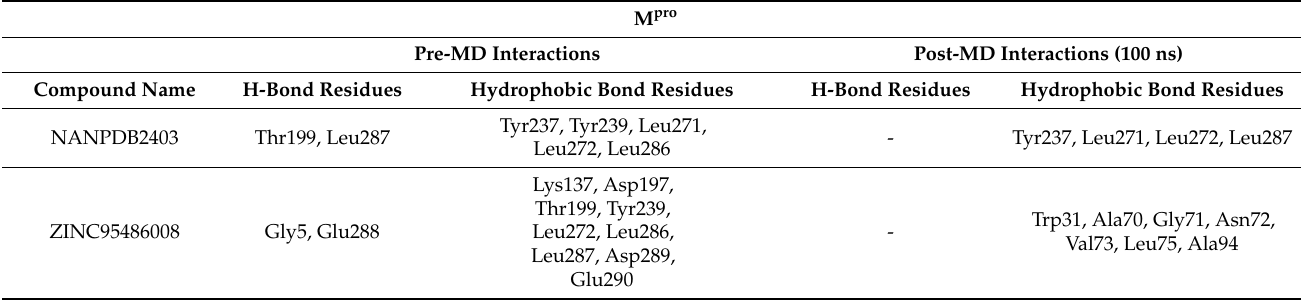
Figure 7. Binding mode characterization using superimposition and LigPlot+ analyses. ( a ) The pre- and post-100 ns MD simulations of M pro -NANPDB2403, and ( b ) M pro -ZINC95486008 complexes. Ligands for the pre- and post-MD simulations are shown in green and cyan colors, respectively. The overlapped interactions between the pre- and post-MD simulations are circled in red color. Table 4. Molecular interactions between potential lead compounds and the M pro target before and after molecular dynamics (MD)